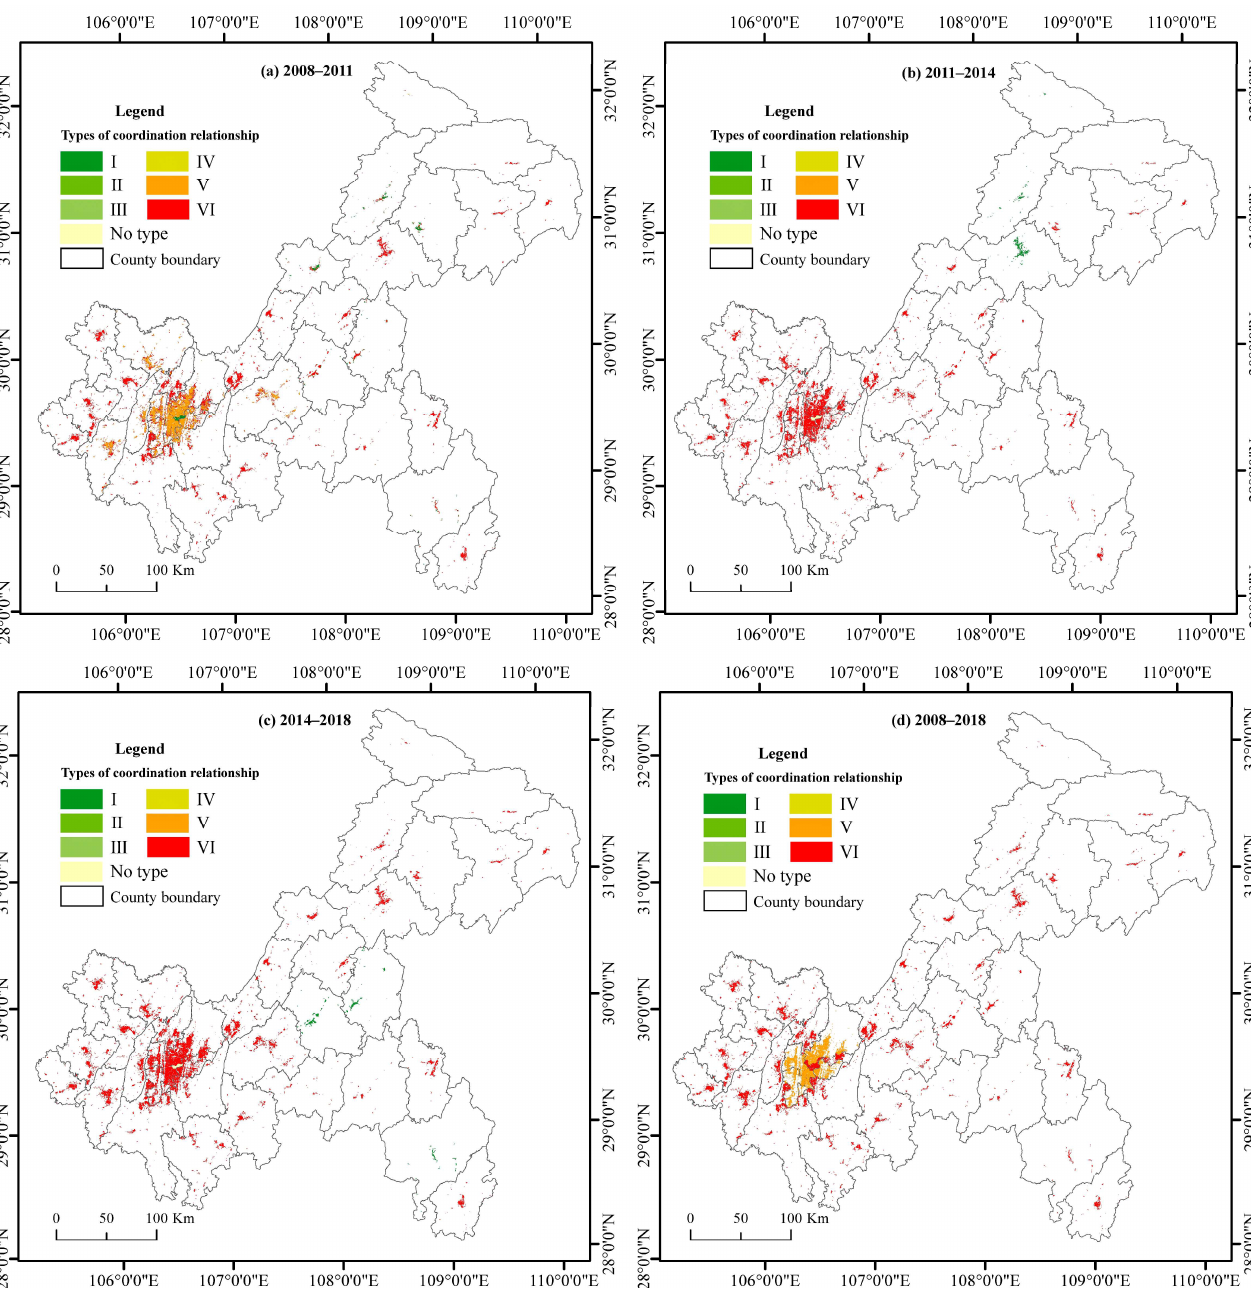
Figure 10. Spatial distribution of coupling linkages in different periods in Chongqing city. The spatial distribution of coupling types of districts and counties in Chongqing during 2008–2011 ( a ), 2011–2014 ( b ), 2014–2018 ( c ), and 2008–2018 ( d ).